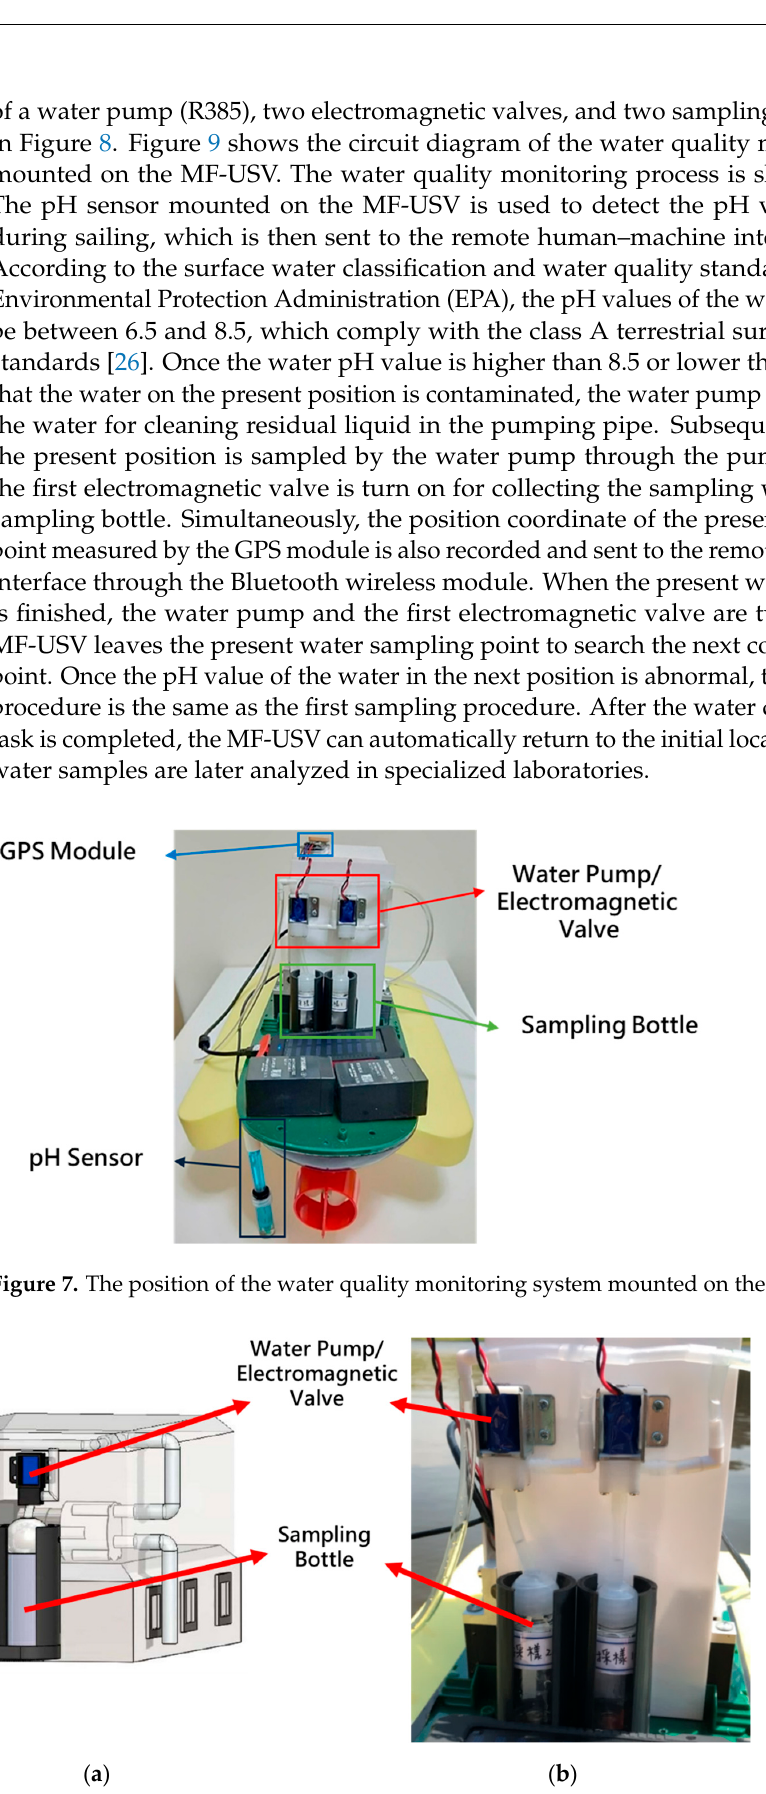
Figure 8. ( a ) CAD design model of the water sample collection device. ( b ) Water sample collection device mounted on the MF-USV.